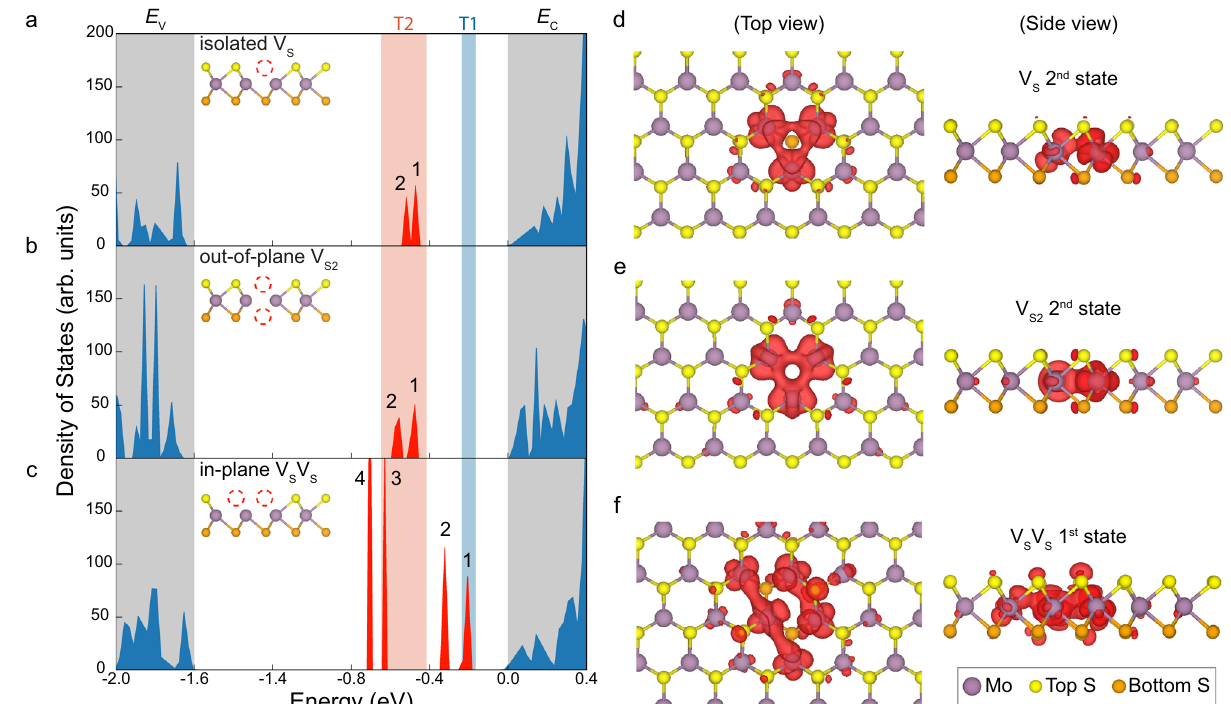
Fig. 5 | Defect energy levels and hybridizationcalculatedby densityfunctional theory (DFT). a – c Calculated density of states (DOS) of a , an isolated single sulfur vacancy (V S ), b , double sulfur vacancies (V S2 ), and c , a neighboring sulfur vacancy pair on the same lattice plane (V S V S ). Inset shows the side view of the vacancy positionsinMoS 2 atomiclattice.Theshadedgrayregionsmarkoutthevalenceand conductionbands. Thecalculated in-gap defectstates are indicated in red,and the blue and orange shaded regions are respectively the T1 and T2 defect states